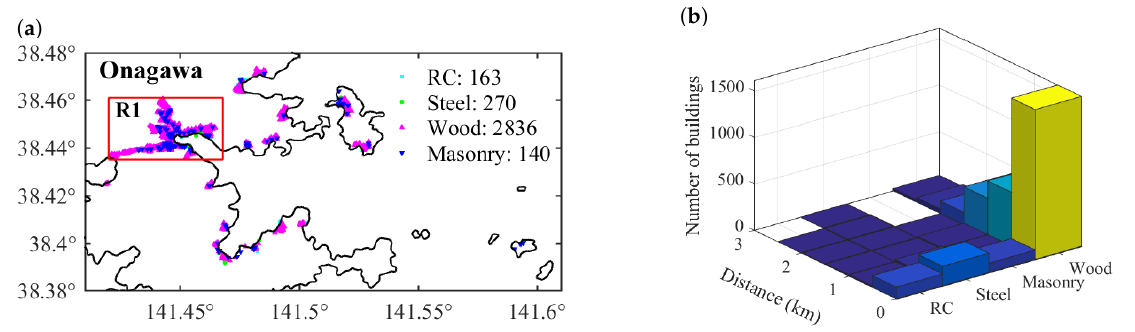
Figure 10. Building portfolio of Onagawa: ( a ) building distribution; and ( b ) number of buildings by distance from the